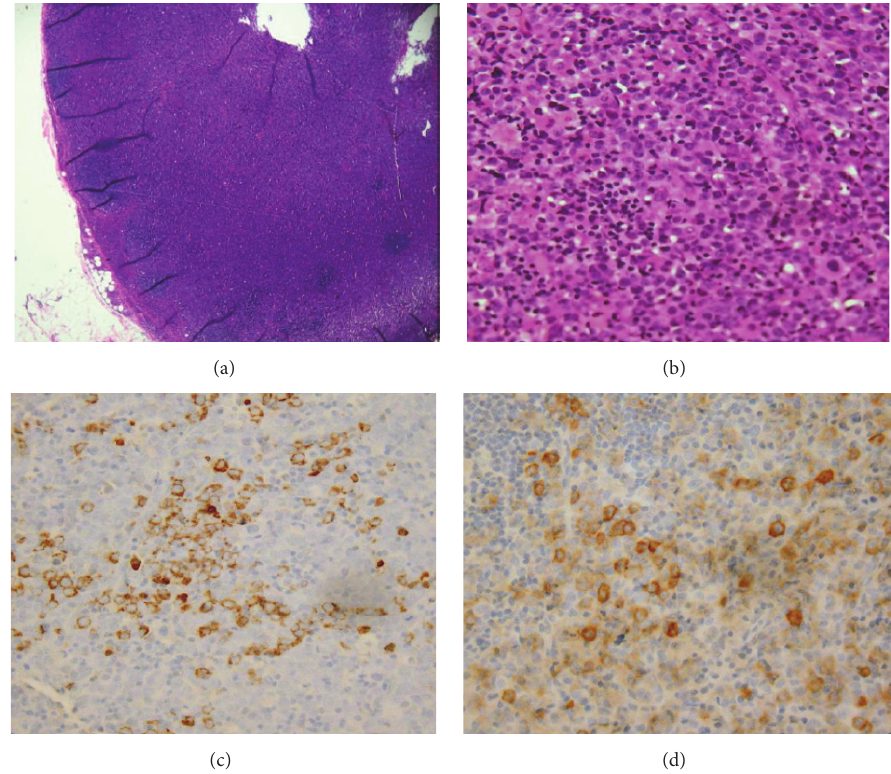
Figure 4: Histopathological analysis. (a) Low magnification view with effacement of lymph node architecture. (b) High magnification view with numerous immature cells (blasts). (c) A proportion of the immature cells are positive for myeloperoxidase by immunohistochemistry. (d) A proportion of the immature cells are positive for CD117 by